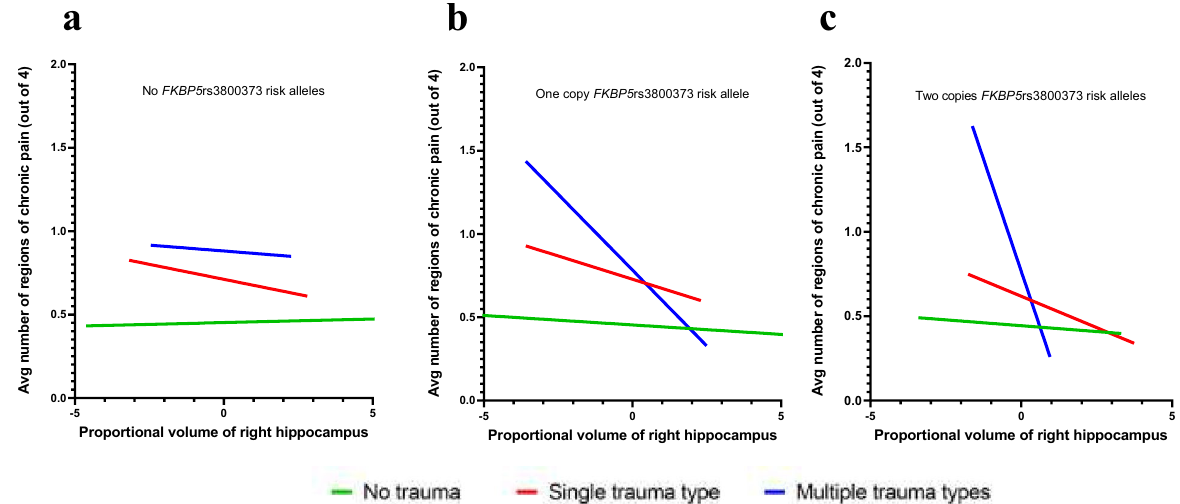
Figure 2. Childhood trauma and FKBP5 rs3800373 risk alleles moderate the relationship between the right hippocampus and CMP severity. Shown is the relationship between right hippocampal brain volume and chronic multisite musculoskeletal pain (CMP) severity in individuals from the UK Biobank study with (a) 0, (b) 1, and (c) 2 FKBP5 rs3800373 risk alleles and varying degrees of childhood trauma (n = 25,280). Right hippocampal brain volume was adjusted for head size and standardized (mean = 0, SD = 1), see “Methods”. Individuals who did not often experience childhood trauma are represented by the green line (“no trauma”), individuals who often experienced one type of childhood trauma are represented by the red line (“single trauma type”), and individuals who often experienced multiple (> 2) types of childhood trauma are represented by the blue line (“multiple trauma types”). As shown in Supplementary Table 8, the interaction between FKBP5 rs3800373, right hippocampal volume, and childhood trauma was statistically significant (p <